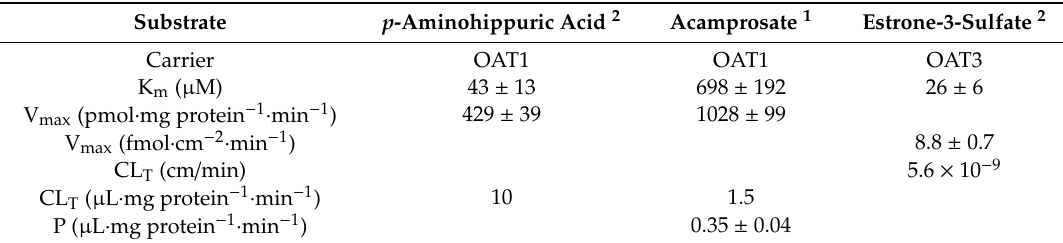
Table 1. Kinetic parameters associated with the uptake of p -aminohippuric acid and acamprosate, substrates for OAT1, and of estrone-3-sulfate, a substrate for OAT3, in HEK293-Flp-In OAT1 and OAT3 cells, respectively. Data are reported as mean ± SEM of replicates in three cell passages obtained in 1 Lab. 1 or 2 Lab. 2.